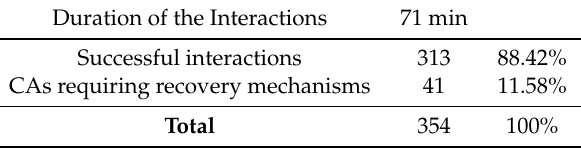
Table 3. Global statistics about the interactions.